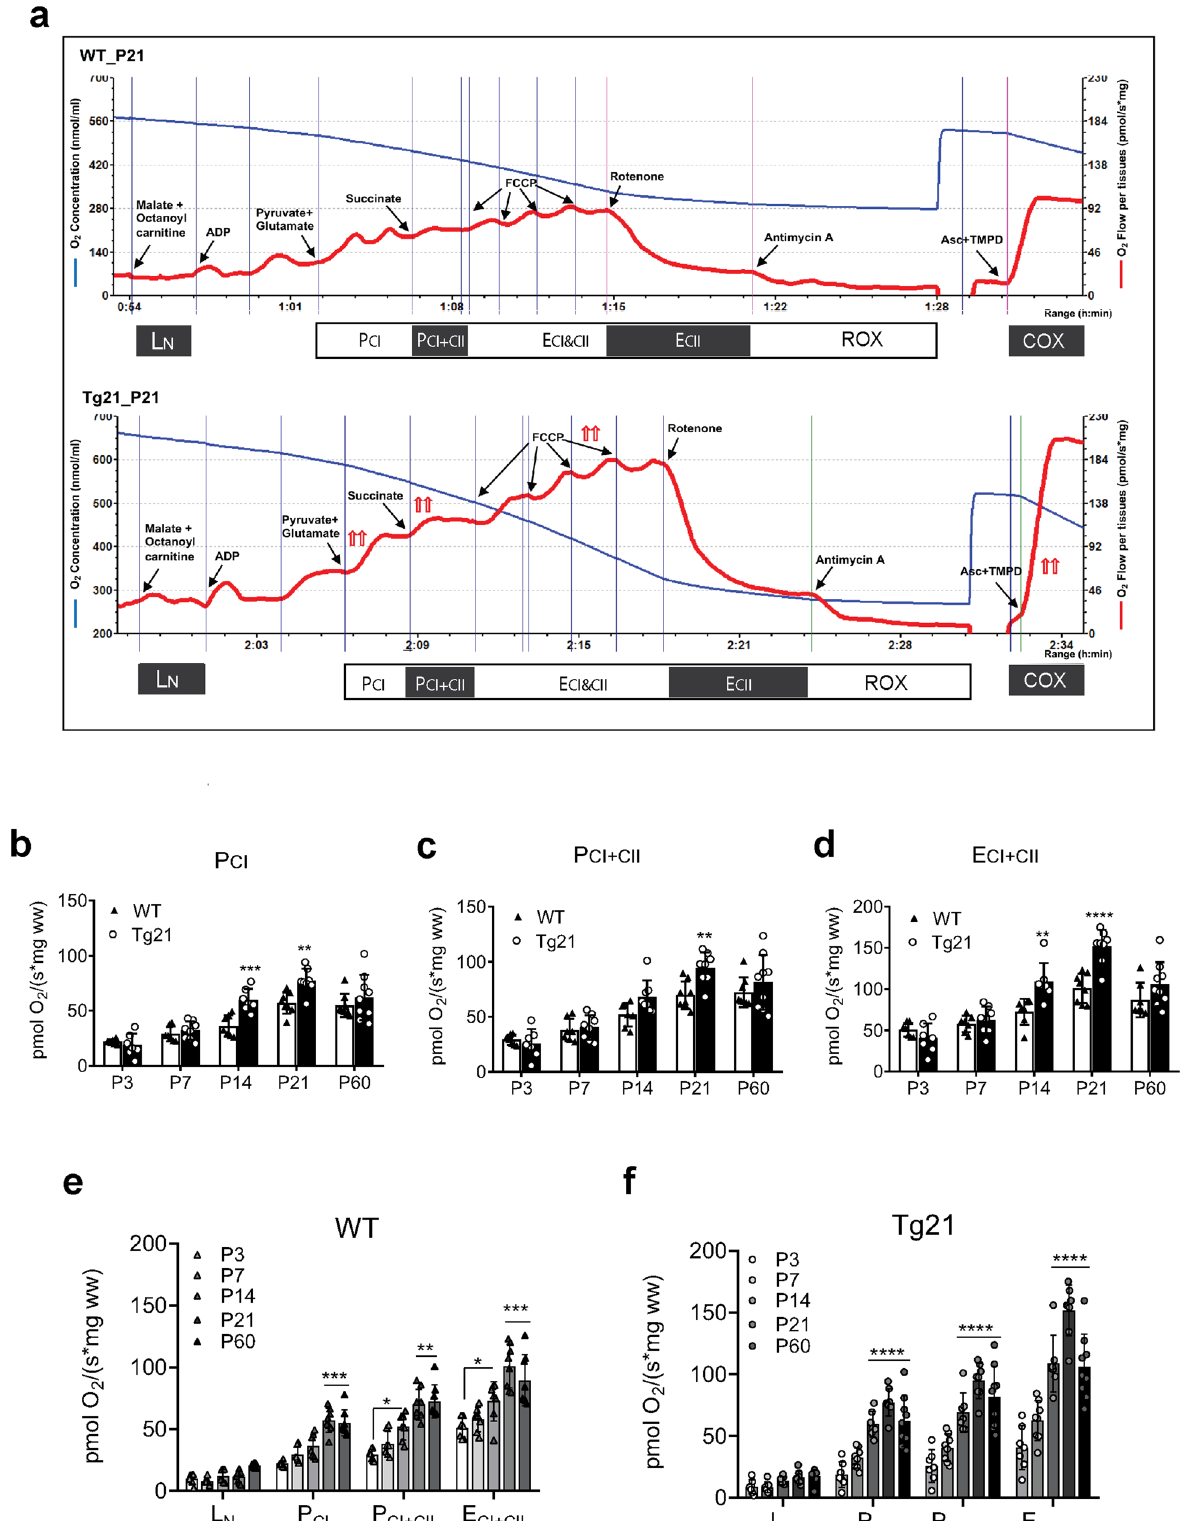
expression at P14 and 1.6-fold more protein at P21 compared to WT (2-way ANOVA, F (1,16) = 73.94, p < 0.0001; Fig. 4c). Mitochondrial proteins speci fi c to the electron transport system were also higher in Tg21 mice compared to WT at various stages throughout postnatal development (Fig. 4d – i). Speci fi cally, complex I (NDUFB8) was 2.7-fold higher at P7 and 4.3-fold